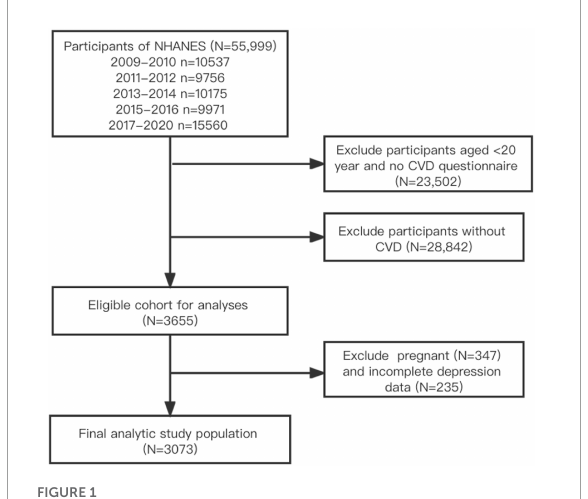
FIGURE1 Flowchart of the screening process for the selection of eligible